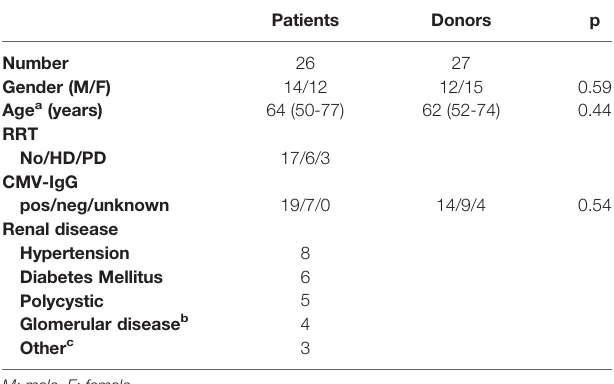
TABLE 1 | Patient and donor characteristics at